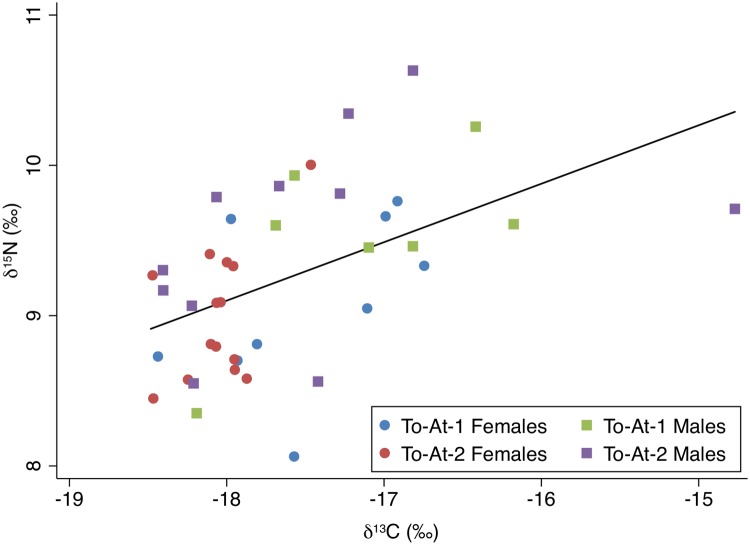
δ13C and δ15N values plotted by sex and burial mound with fitted regression line (y = 0.40x + 16.3, p<0.001).